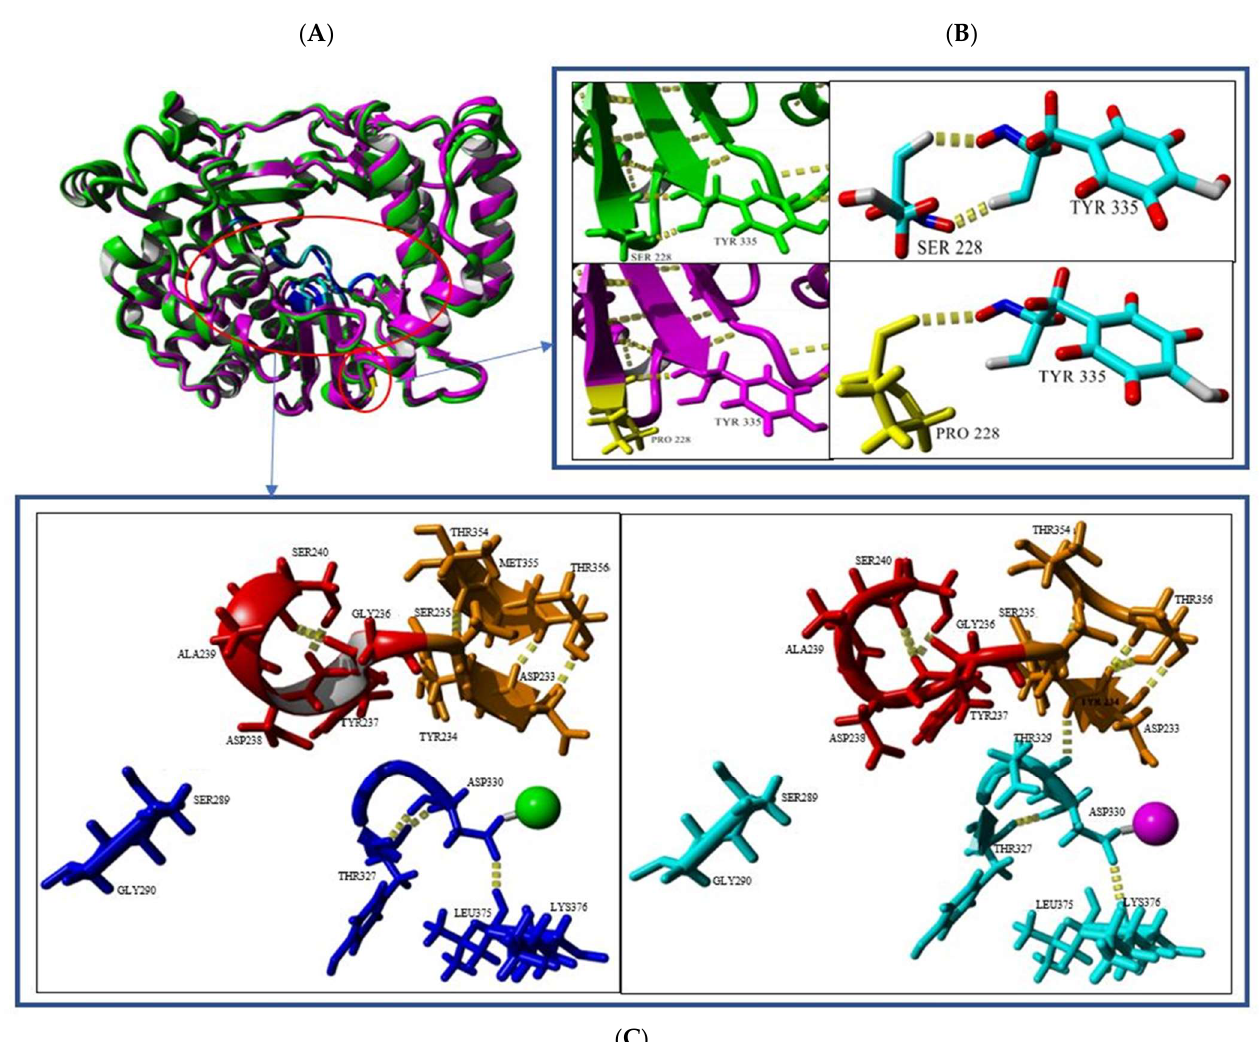
Figure 10. ( A ) The superimposition of the 3D polymerase protein structure of EV-A71/WT and the EV-A71/SP variant. EV-A71/WT is colored in green, while EV-A71/SP is colored in magenta. The active sites of EV-A71/WT consisting of amino acids 233–238, 289–290, 327, 328–330, 375–376 are marked in blue, while the active site of EV-A71/SP is marked in cyan. Mutation S228P is denoted in yellow. ( B ) A close-up view of the S228P mutation found in the 3D polymerase of EV-A71/SP (bottom) when compared with the EV-A71/WT (top). Mutated Pro228 is marked in yellow. Hydrogen bonds are denoted as yellow dotted lines. ( C ) A close-up view of the differences between the active site in the 3D polymerase of EV-A71/SP variant (right) when compared with EV-A71/WT (left). Turn structure within the active site of the EV-A71/WT and equivalent amino acids in the EV-A71/SP are marked in red. Interaction of Ser240 towards Gly236 and Asp237 are responsible for the formation of turn structure in the active site of EV-A71/WT. A longer sheet structure was found in Asp233-Ser235 of the EV-A71/WT active site, which were formed through Ser235-Thr354 and two hydrogen bonds between Asp233-Thr356, whereas three hydrogen bond interactions between Asp233-Thr356, Tyr234-Thr356 of the EV-A71/SP active site caused a shorter sheet to be formed. EV-A71/SP active site had an extra hydrogen bond between Tyr234-Asp329. Asp330 of the EV-A71/WT active site formed two hydrogen bonds with Tyr327 and one hydrogen bond with Leu375, whilst Asp330 of EV-A71/SP active site formed hydrogen bond interactions with Tyr327 and Lys376,